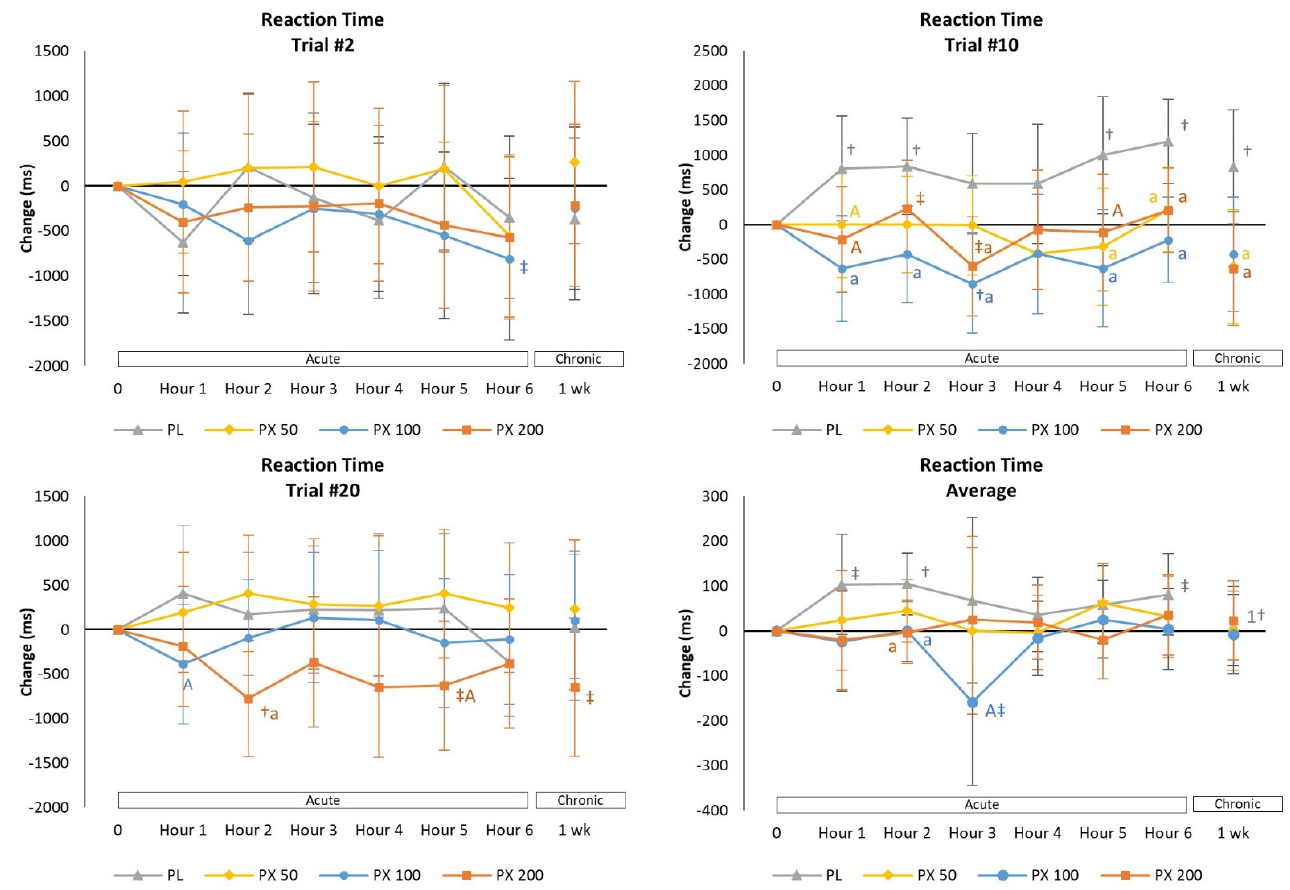
Figure 6. Mean changes with 95% Confidence Intervals in Psychomotor Vigilance Task Test data. † = p < 0.05 (‡ = p > 0.05 to p < 0.10) from baseline. 1† = p < 0.05 from Day 1–1 h value. Treatment differences are denoted as from PLA: a = p < 0.05 (A = p > 0.05 to p < 0.10); PXN 50: b = p < 0.05 (B = p > 0.05 to p < 0.10); PXN 100: c = p < 0.05 (C = p > 0.05 to p < 0.10); and PXN 200: d = p < 0.05 (D = p > 0.05 to p < 0.10.